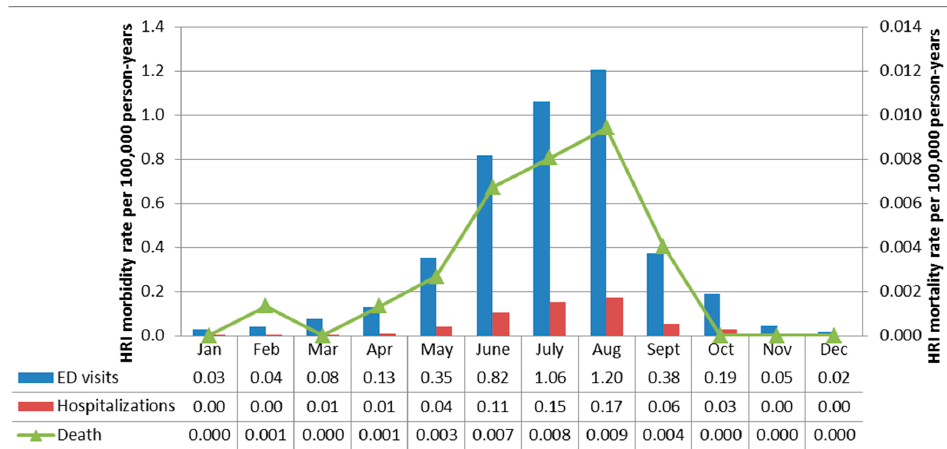
Figure 2. Work-related HRI morbidity and mortality rates for Florida residents stratified by month and data source, 2005–2012 (Total cases: ED visits = 3234; Hospitalizations = 432; Deaths = 25). All rates are per 100,000 person-years. Note that the morbidity rates (left y-axis) are two orders of magnitude larger than the mortality rates (right y-axis).